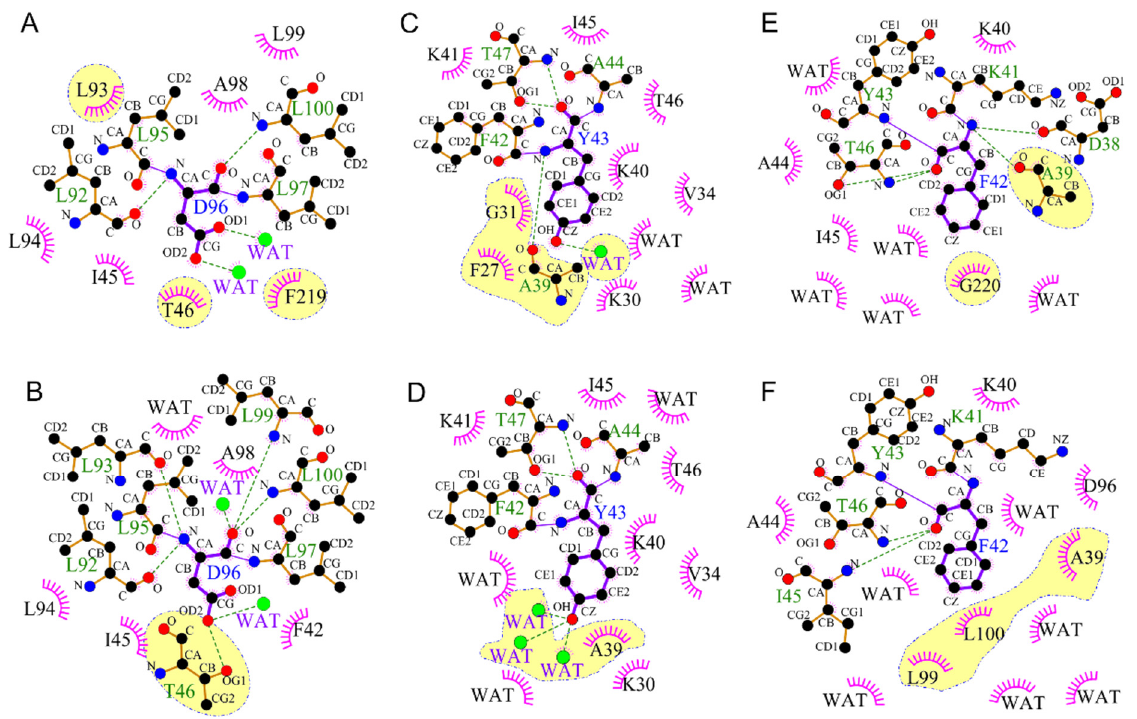
Figure 7. Schematic diagram of the H-bond (green dotted lines) and hydrophobic interactions (pink spoked arcs) around D96 ( A , B ), Y43 ( C , D ), and F42 ( E , F ) in WT-M 2 ’ ( A , C , E ) and Y185F-M 2 ’ ( B , D , F ). Only the van der Waals contacts between the residues with the closest distance less than 4.0 Å are considered.